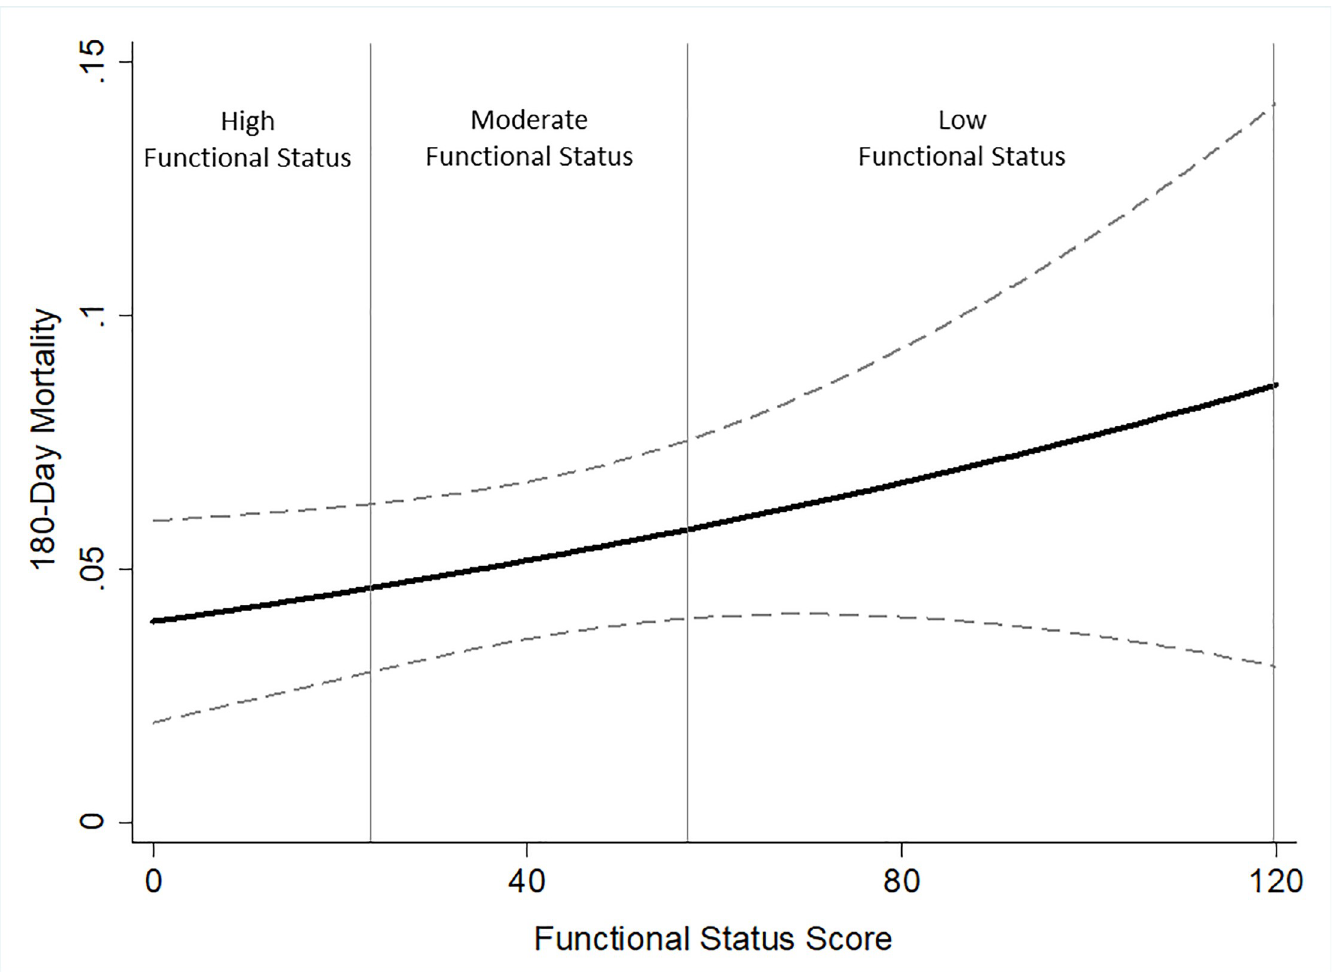
Fig 1. Adjusted association of functional status and 180-day mortality. Regression coefficient plot of multivariate estimates of the pre-CABG functional status- mortality association with 95% confidence intervals (dashes). Multivariate estimates adjusted for age, gender, New York Heart Association Class III/IV, Chronic Lung Disease, Hypertension, Diabetes, Cerebro-Vascular Disease and the STS